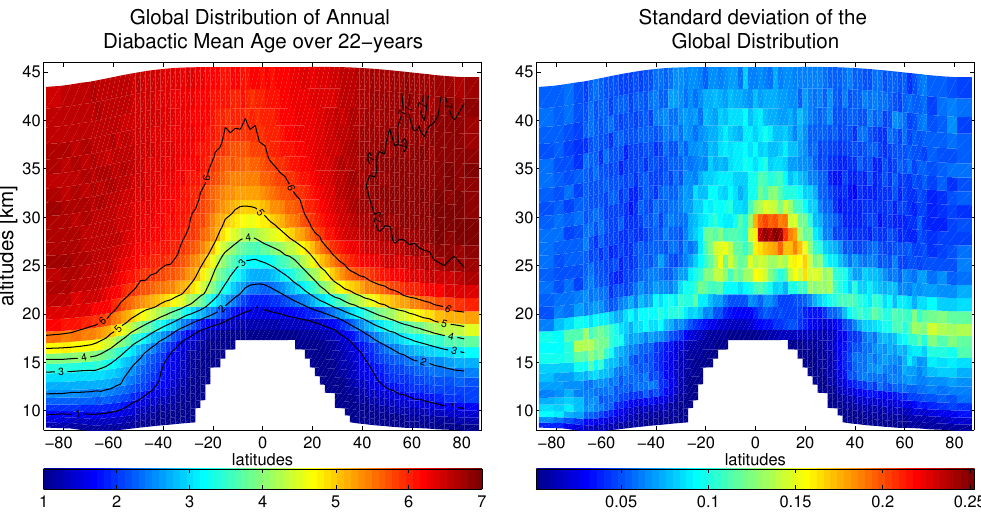
Fig. 2. (Left): distribution of mean age of stratospheric air (in yr) averaged over 22yr (264 months, 1989-2010) as a function of latitude and altitude. (Right): estimated standard deviation of the mean age (in yr).